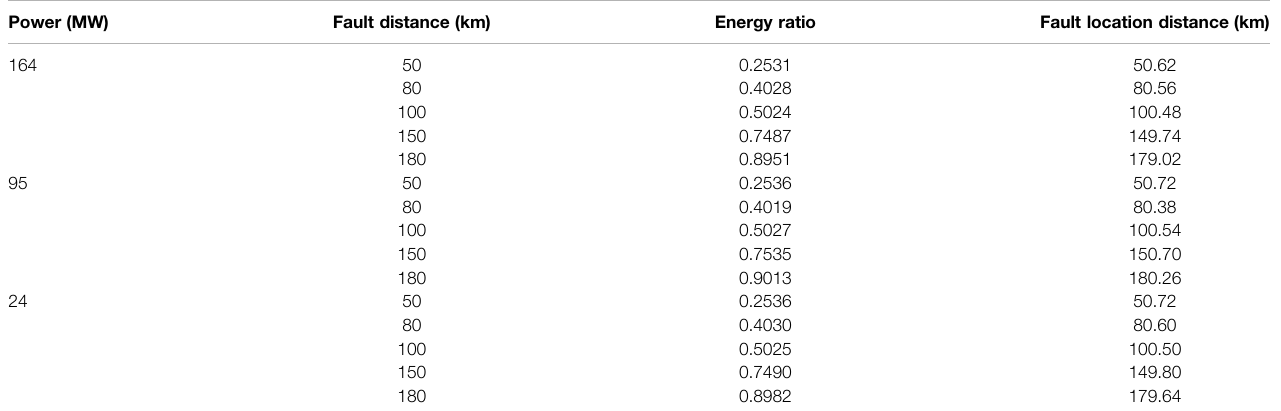
TABLE 3 | Bipolar same position abnormal grounding distance measurement.